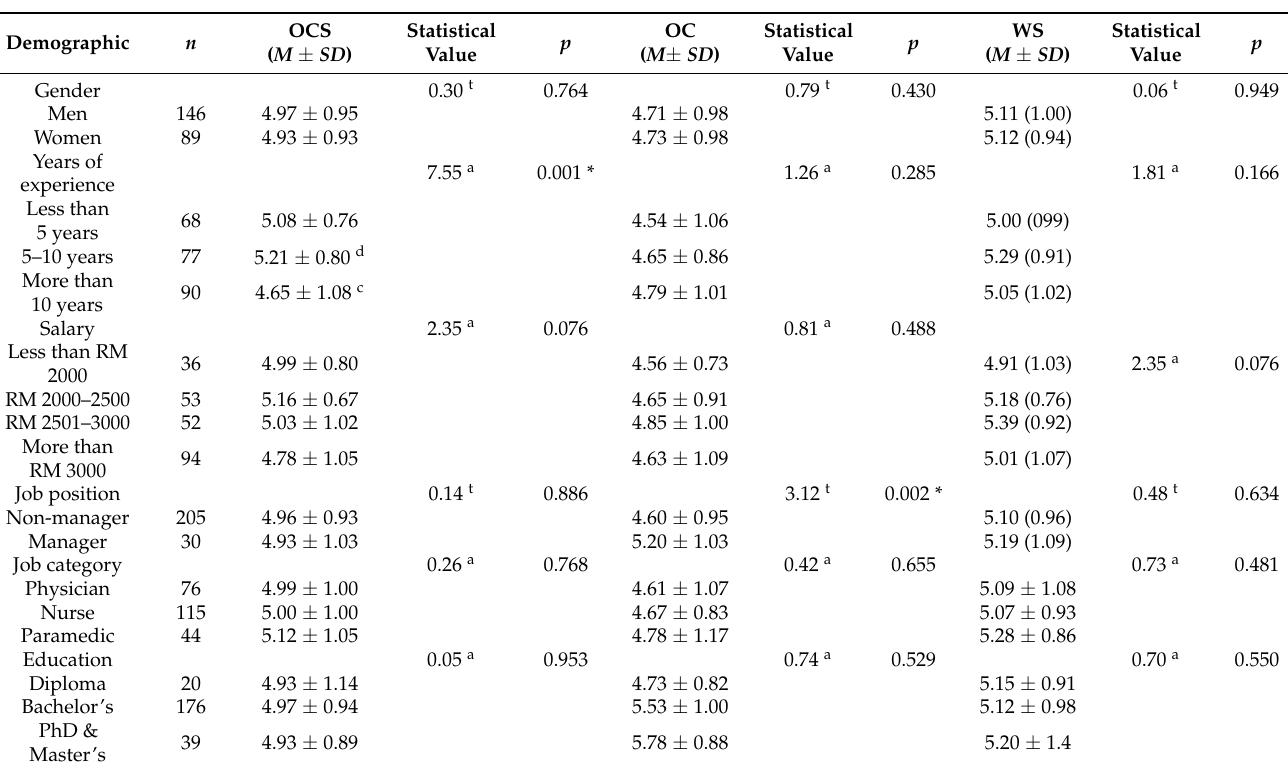
Table 1. HCPs’ organizational communication satisfaction and organizational commitment according to demographic characteristics (N =